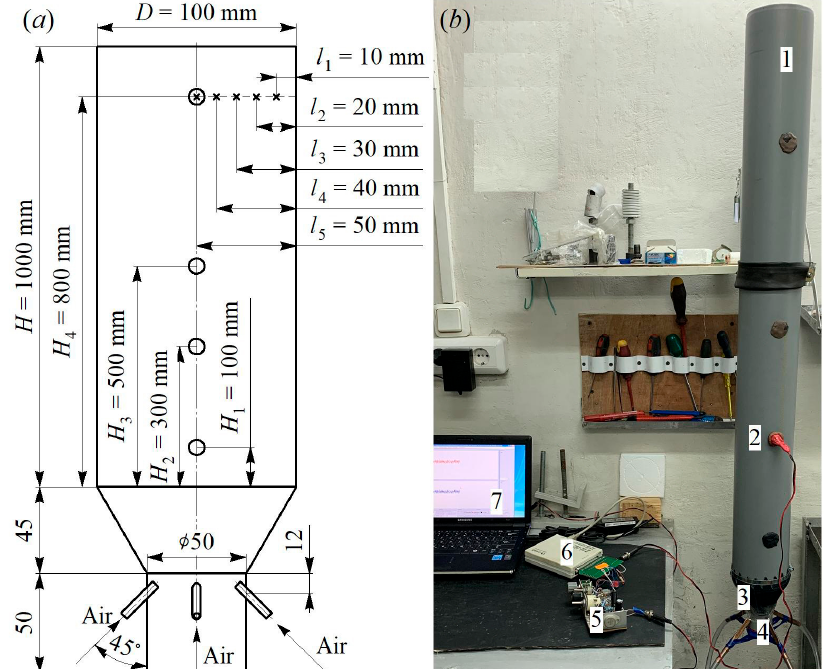
Figure 1. Size dimensions ( a ) and photograph ( b ) of the experimental set-up for studying the aerodynamic characteristics of flows in a vertical diffuser: 1—cylindrical part of the set-up; 2—hot-wire anemometer sensor; 3—diffuser; 4—base with supply tubes; 5—hot-wire anemometer for measuring instantaneous values of flow velocity; 6—analogue-to-digital converter; 7—laptop for collecting and processing experimental findings; H , H 1 ... H 4 —height of the cylindrical part in the diffuser; l 1 ... l 4 —linear dimension along the diameter of the cylindrical part of the